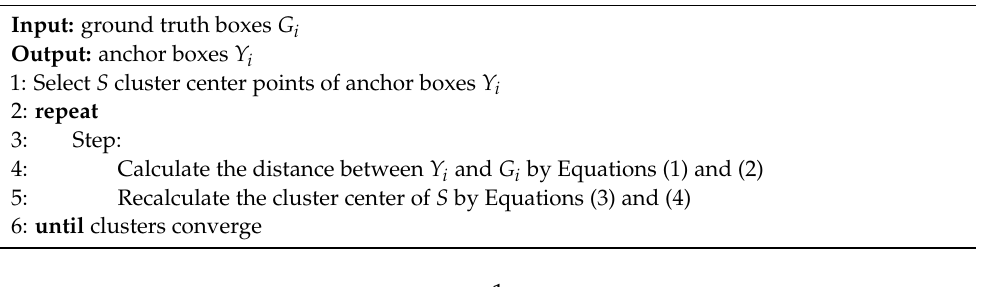
Algorithm 1. The procedure for setting sizes of anchors